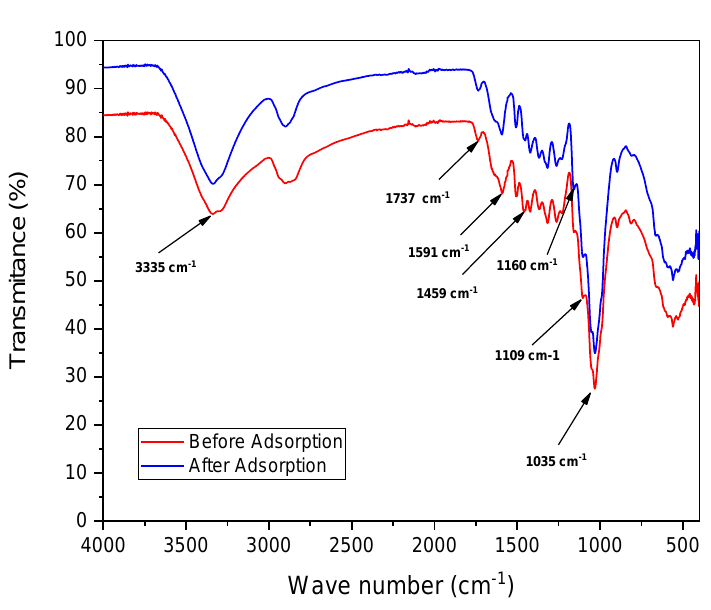
Fig. 2. FT-IR spectra of PEI/DSNP before and after Pb 2+ adsorption.